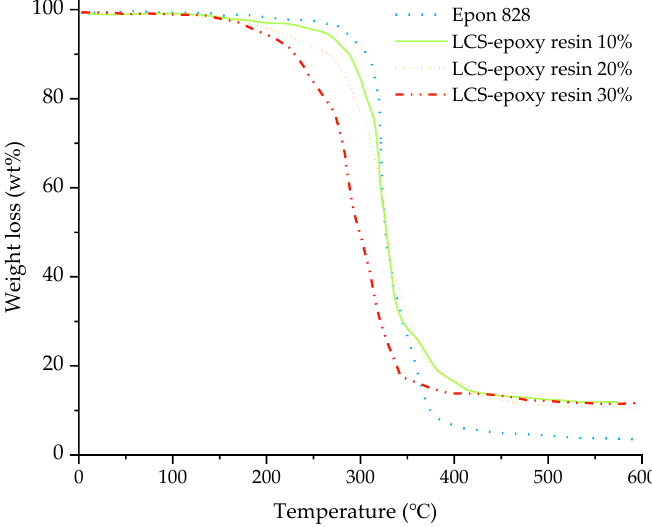
Figure 5. Thermogravimetric curves of the cured epoxy resins.